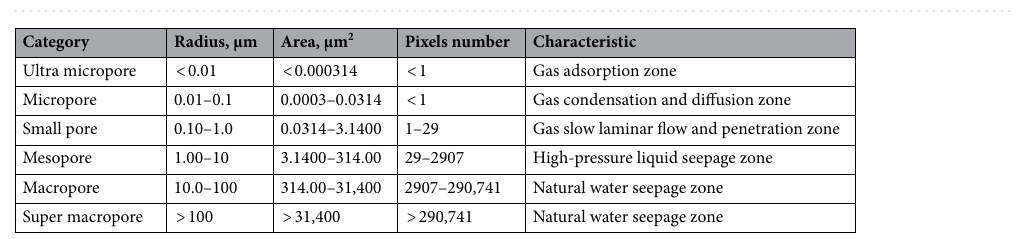
Table 2. Classification of pore and the number of pixels